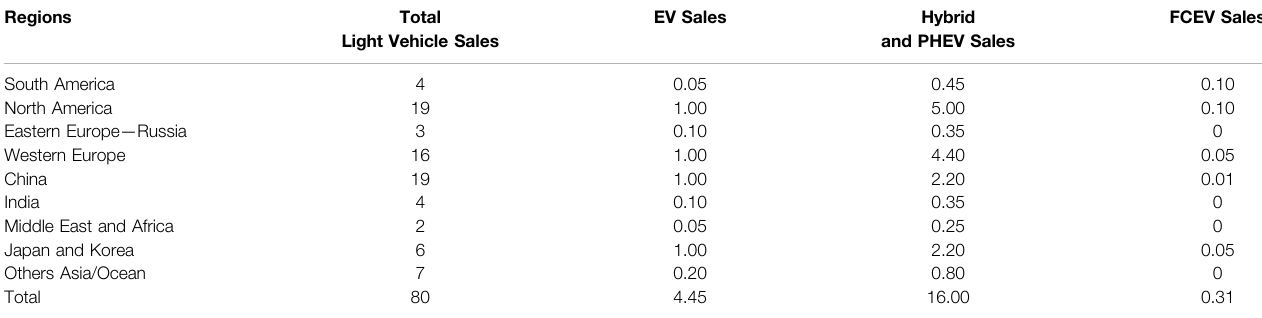
TABLE 10 | Global light duty electric vehicle sales forecast for 2030, in millions of units, with optimistic forecast. Data from (Sustainable Energy Ireland (SEI), 2015).